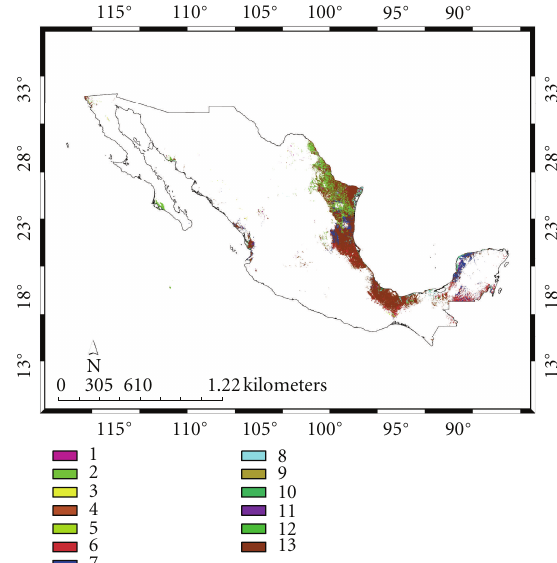
Figure 8: Species distribution model and vegetation types for Amblyomma cajennense : (1) grassland; (2) scrubland; (3) pine forest; (4) oak forest; (5) pine-oak forest; (6) tropical rainforest; (7) tropical deciduous forest; (8) aquatic inland vegetation; (9) cloud forest; (10) mangle; (11) palms/palm plantations; (12) savanna; (13) other vegetation types/not